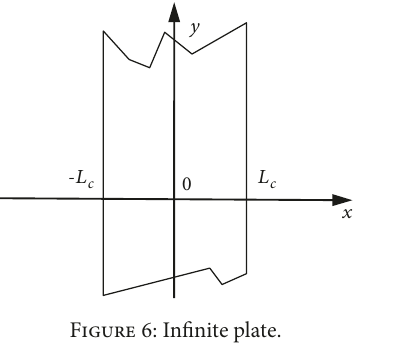
Figure 6: Infinite